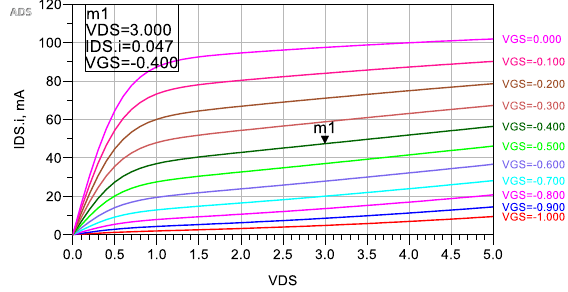
Fig. 1. DC analysis curves (active device ATF21170)